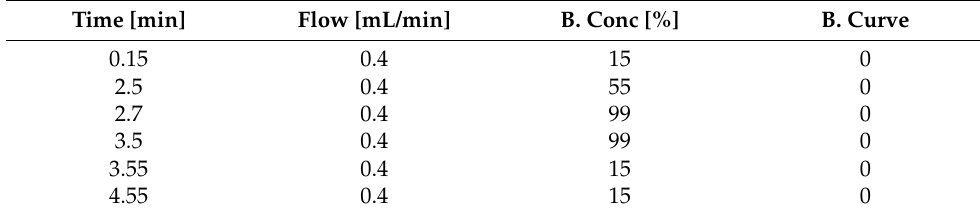
Table 4. Conditions of chromatographic